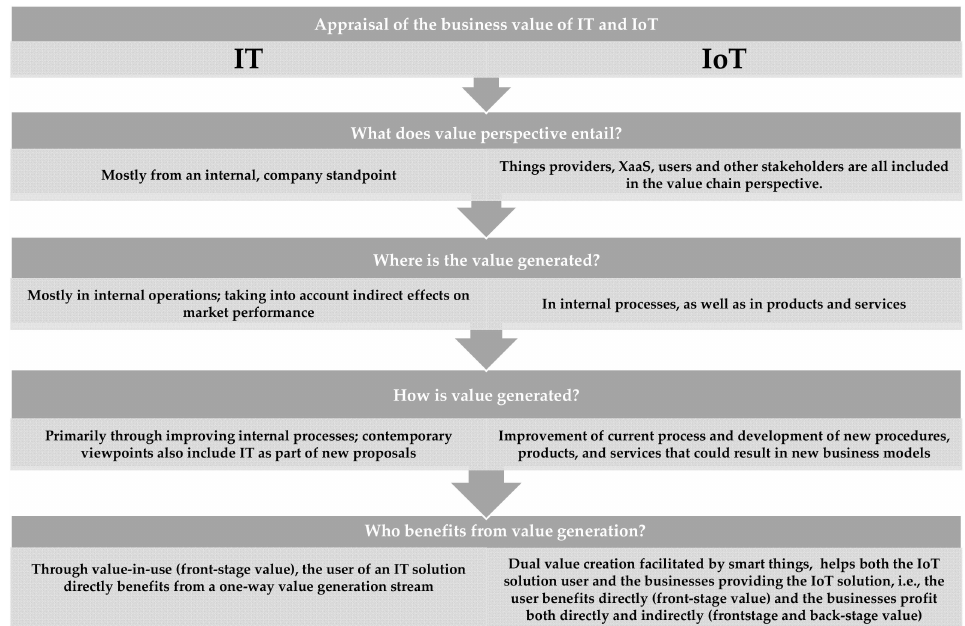
Figure 4. Appraisal of the business value of IT and